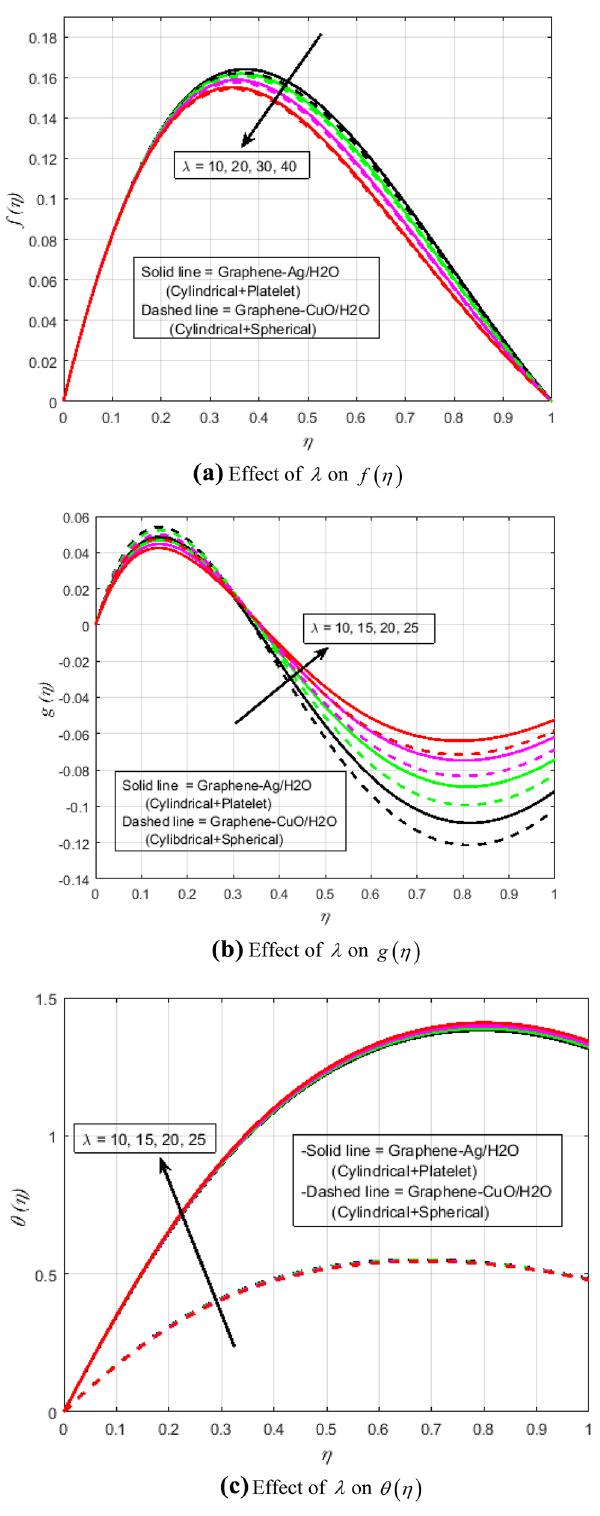
Figure 4. (a) Effect of (cid:31) on f (η) . (b) Effect of (cid:31) on g (η) . (c) Effect of (cid:31) on θ(η)